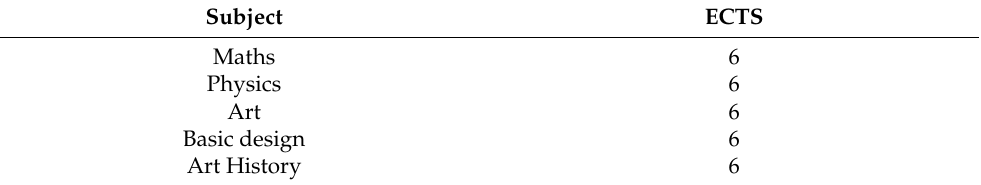
Table 1. First year subjects.